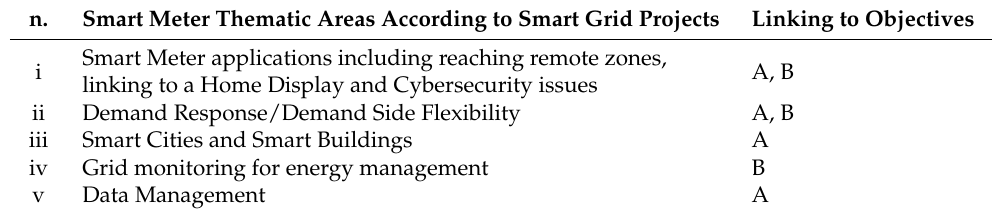
Table 12. Main points of interest regarding smart metering applications as indicated by the smart grid projects